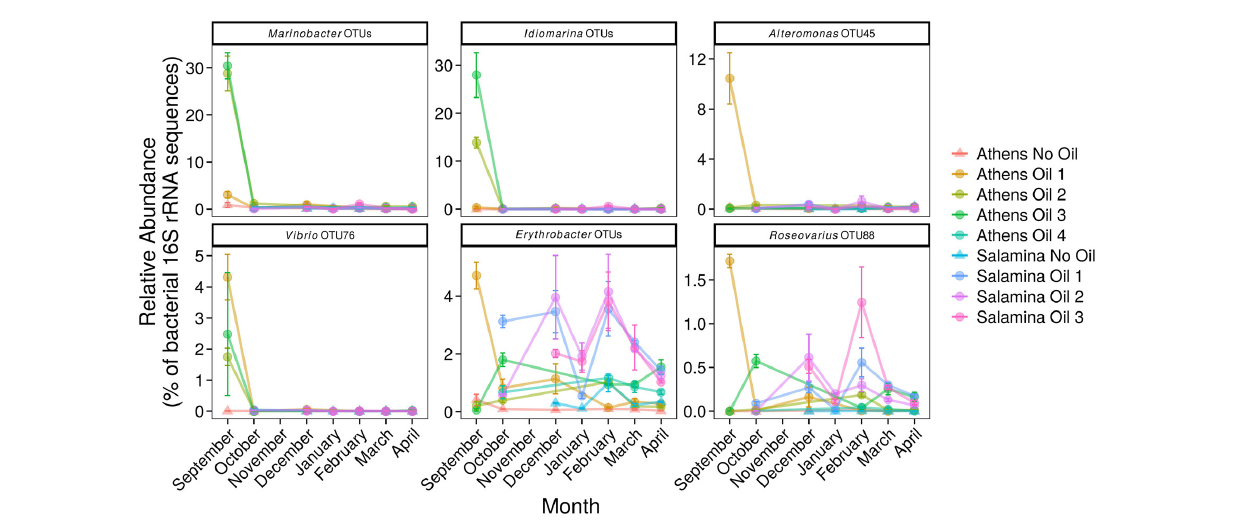
FIGURE 5 | Relative abundance (% of the bacterial community; mean ± SE, n = 3) of 16S rRNA gene OTUs assigned to Bacteria associated with oil-degradation, in sediments from control (Suffix “No Oil”) and contaminated (Suffix “Oil”) sites along the Athens Riviera and Salamina coastline, from September 2017 to April 2018. No samples were collected for all Salamina sites in September 2017, “Salamina No Oil” in October 2017, or all Salamina and Athens sites in November 2017. Bacteria and archaea OTU tables are available in Supplementary Tables S3 , S4